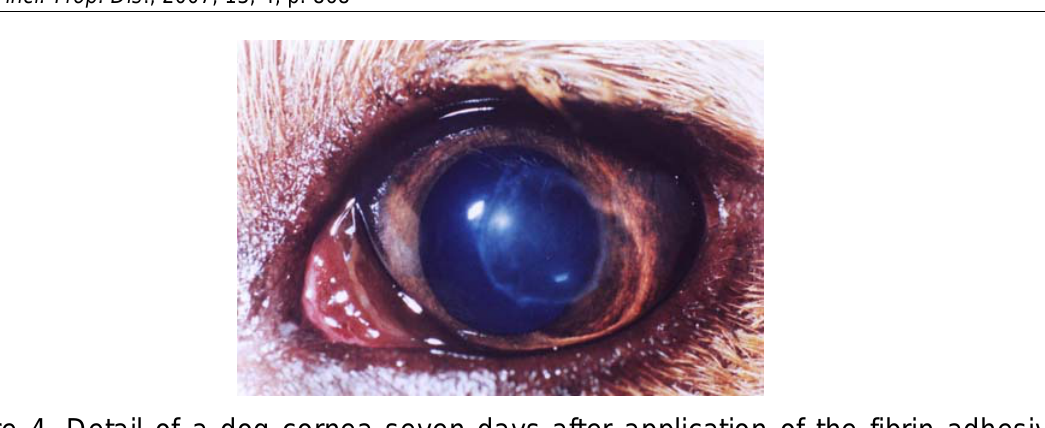
Figure 4. Detail of a dog cornea seven days after application of the fibrin adhesive derived from snake venom in an animal of Group 3. There is an increase in opacity at the periphery of the keratectomized area, indicating the progress of a scar formation.